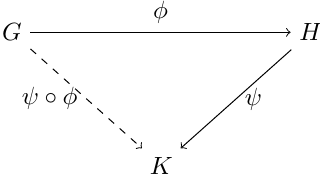
Figure 1. Composition of